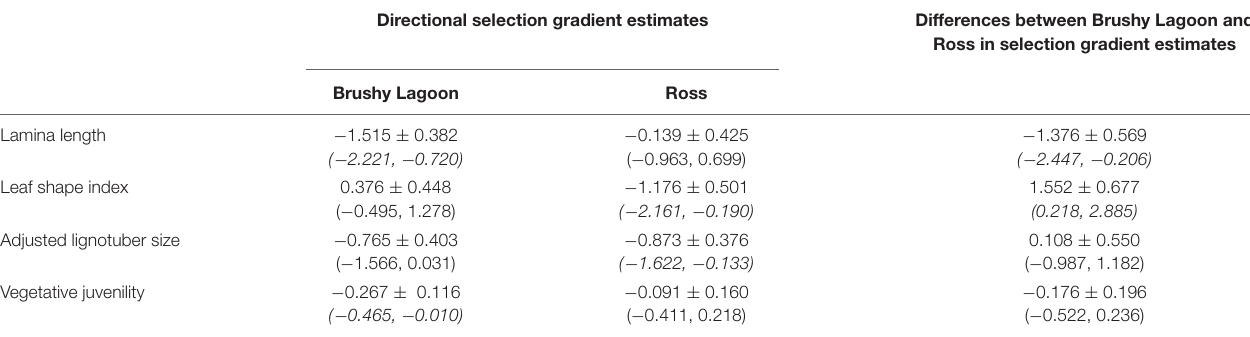
TABLE 5 | Estimates of directional selection gradients, and their population differences, for four functional traits (lamina length, leaf shape index, adjusted lignotuber size and vegetative juvenility) measured in the mesic (Brushy Lagoon) and dry (Ross) populations of E. pauciflora